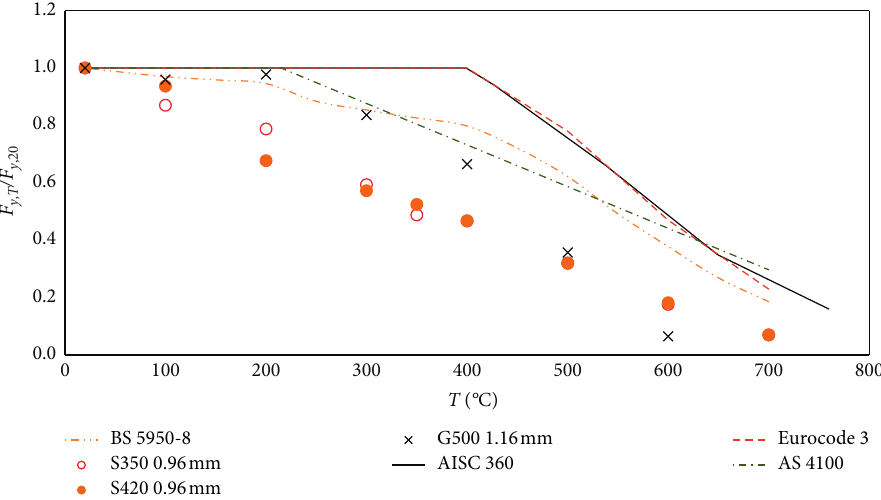
Figure 17: Comparison of the retention factors of yield strength according to test results with the current design